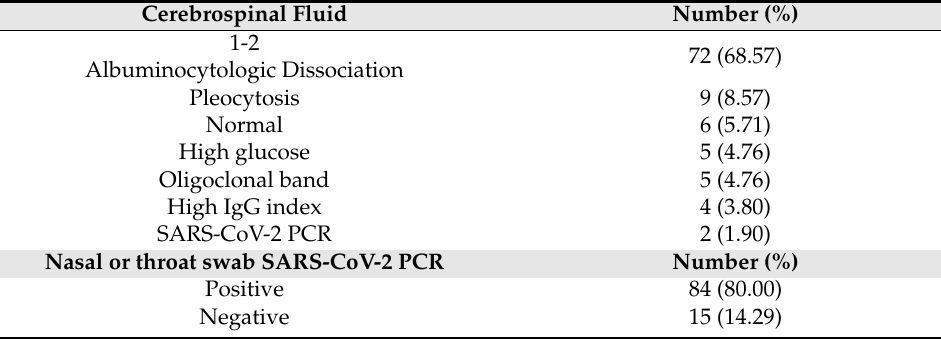
Table 9. Cerebrospinal fluid analysis and SARS-CoV-2